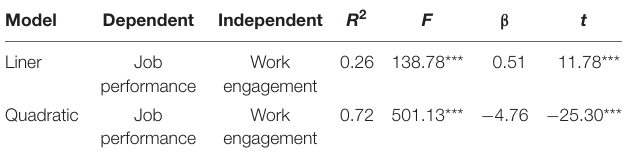
TABLE 2 | Linear and curvilinear estimation of work engagement and job